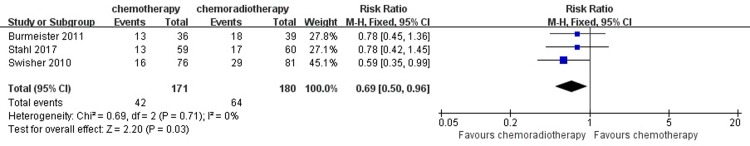
Forest plot of the included studies for 5-year survival.M-H, Mantel-Haenszel.